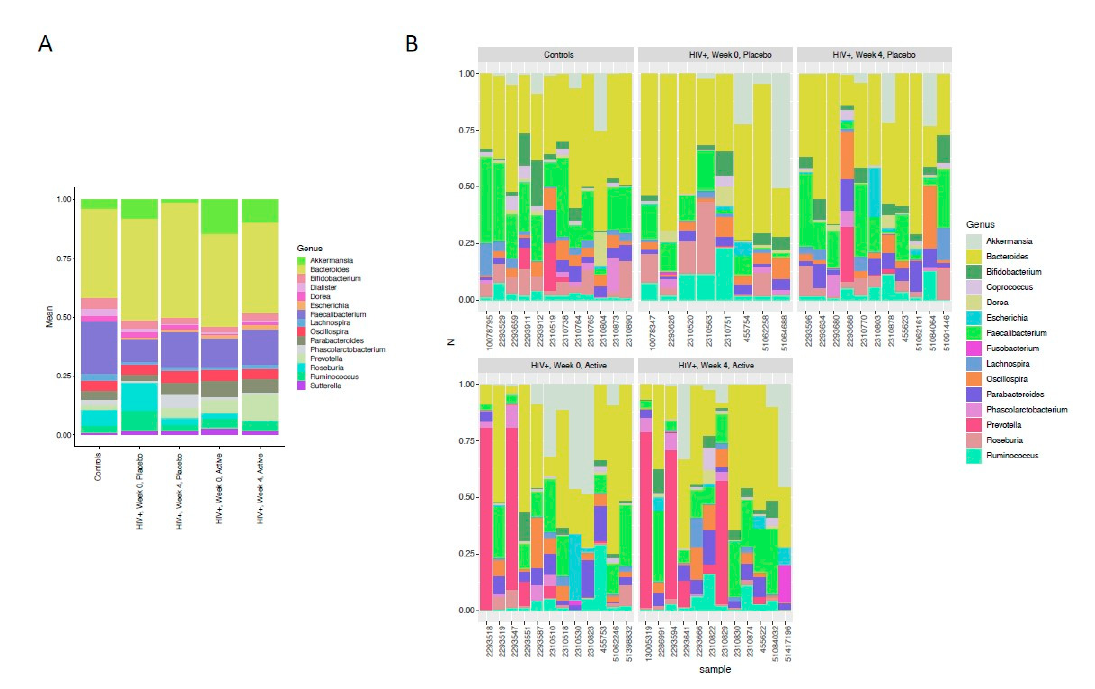
Figure 3. Relative abundance of top 15 more prevalent genus. Differences between the HIV-infected vs. the control groups could be appreciated, without clear differences related to the intervention.